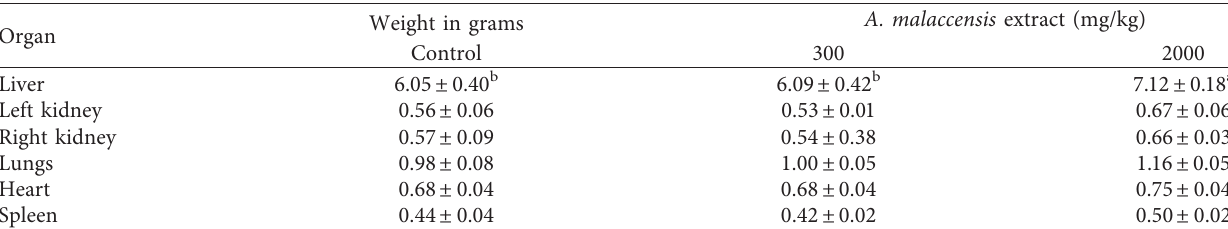
Data with different lower case letters are significantly different ( p < 0 .